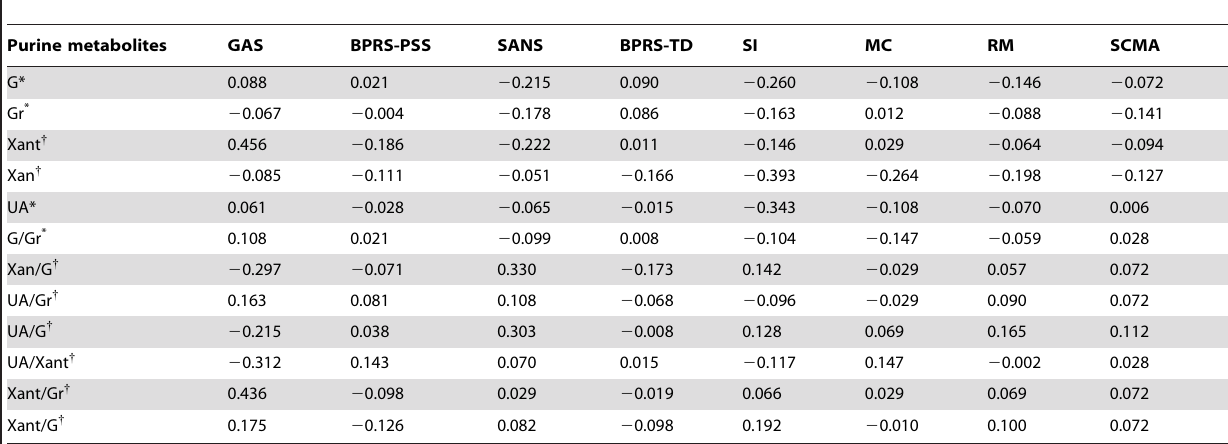
Table 4. Correlation coefficients between purine metabolites and clinical assessments from first-episode neuroleptic-naive patients with schizophrenia 4 weeks after initiating antipsychotic treatment.